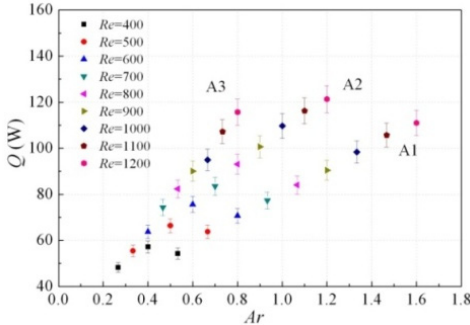
Figure 11. Heat transfer rate variation with A r , Va = 150.